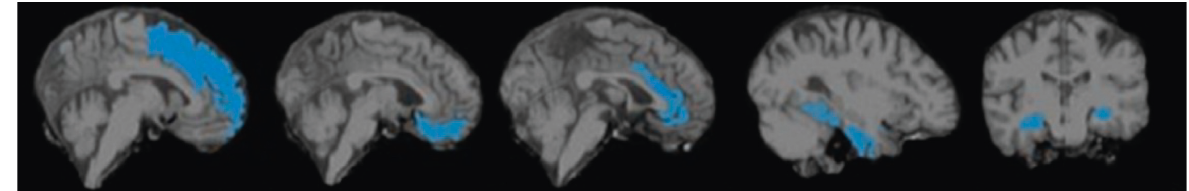
Figure 2: Volumetric regions-of-interest (ROIs). The figure depicts the masks used for volumetric ROI analyses from left to right: prefrontal cortex, orbitofrontal cortex, anterior cingulate cortex, medial temporal cortex, and hippocampus. Masks are superimposed on a repre- sentative T 1 -weighted image from a participant in our sample.